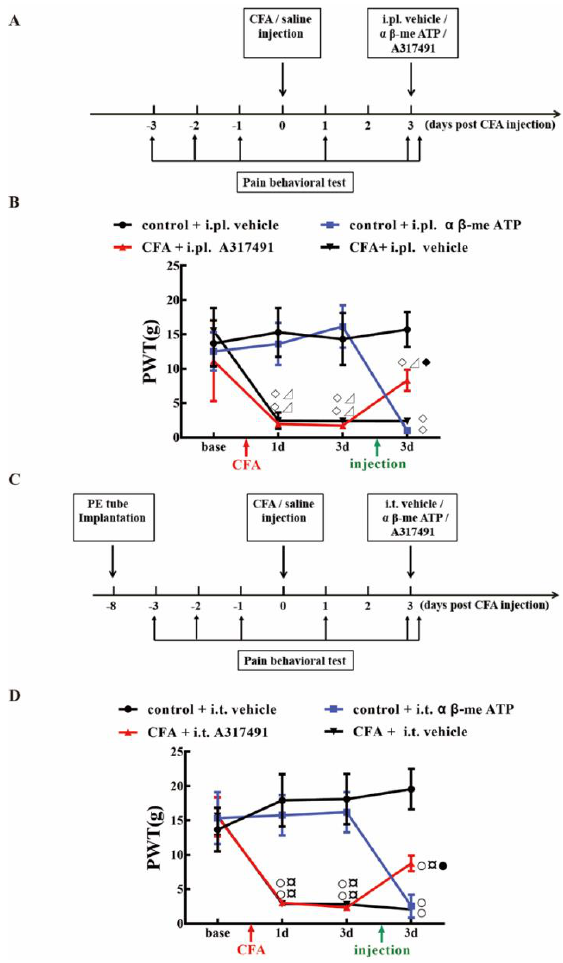
Figure 7. The effect of intraplantar injection or intrathecal injection of α β -me ATP (P2X3 agonist) and